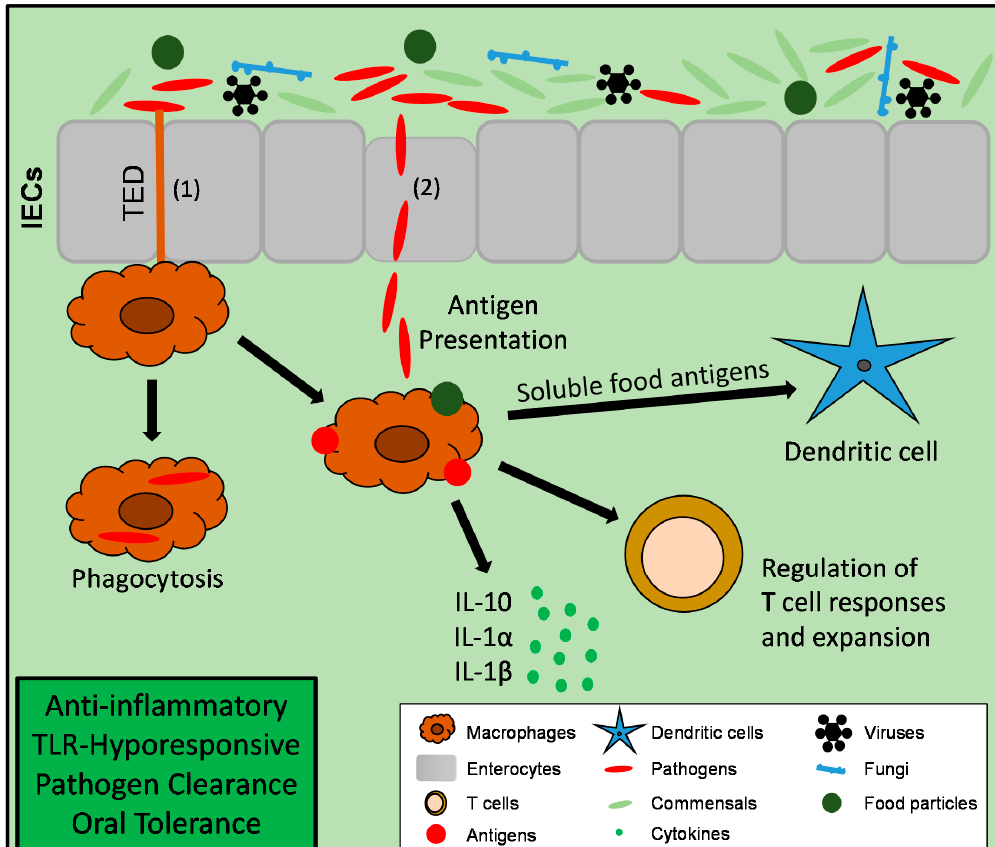
Figure 2. Macrophages in the intestine under homeostatic conditions. Macrophages take up bacterial antigens or food particles either with help of their transepithelial dendrites (TED, 1) or via the entry route through epithelial M-cells (2). Intestinal macrophages phagocytose and eliminate invading pathogens while at the same time preventing overwhelming immune responses due to their TLR-hyporensponsiveness. They present foreign antigens or food particles to dendritic cells and also T-cells, an important step to mediate T cell regulation and food tolerance. They are characterized by an anti-inflammatory gene expression profile with spontaneous expression of high amounts of IL-10 , which plays a key role for the maintenance of intestinal homeostasis.